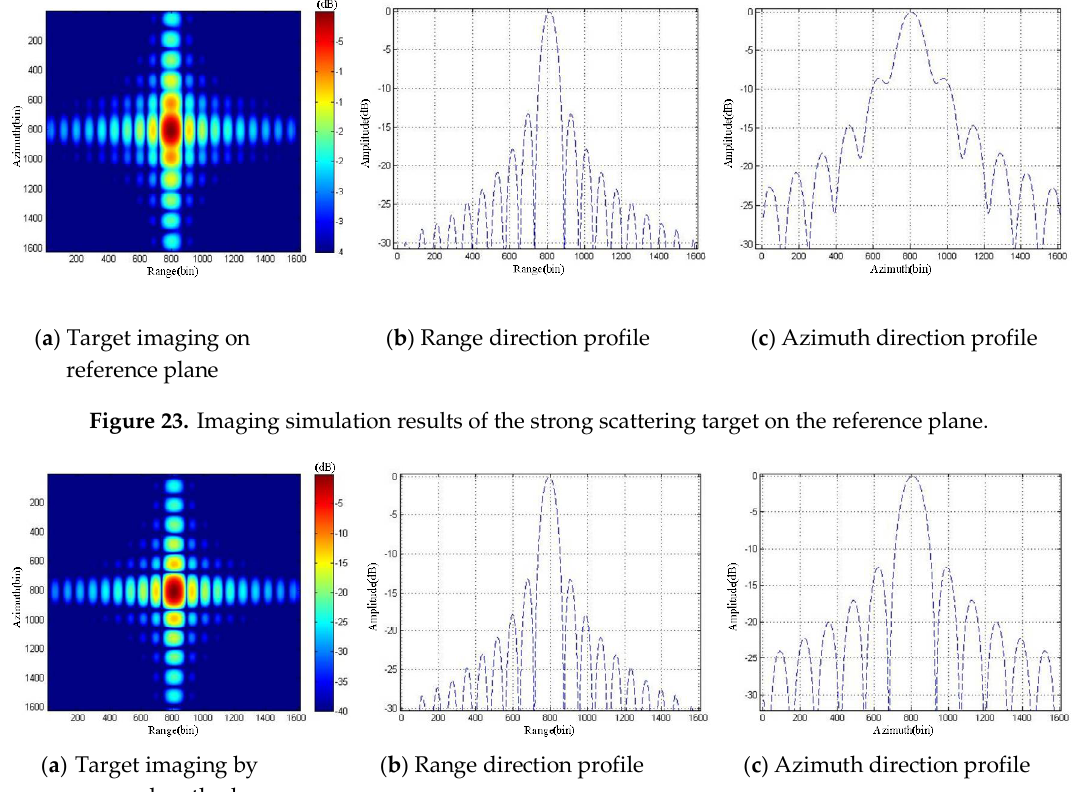
Figure 22. The distributed scenes imaging simulation results of ArcSAR in Cartesian coordinate system by traditional method and proposed method.